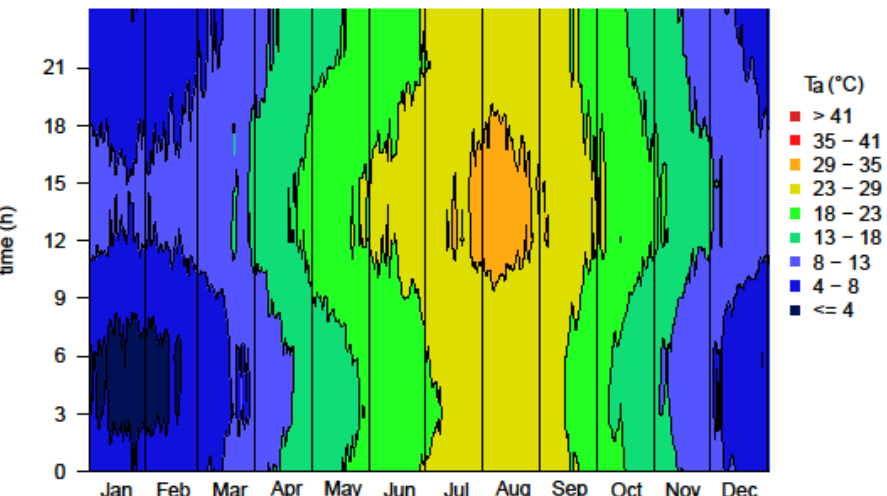
Figure 8. Temporal diagram for mPET for Tokyo during the period August 1966 to June 2018 (3 h